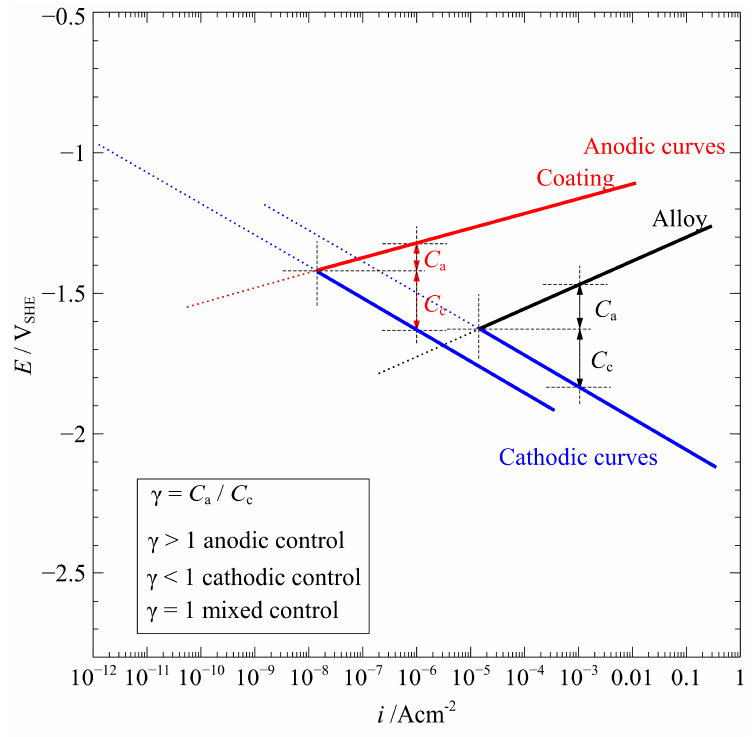
Figure 10. An ideal schematic mechanism of anodic and cathodic curves for AZ91 alloy and MAO- coated alloy after 1 h immersion in a 3.5% NaCl.